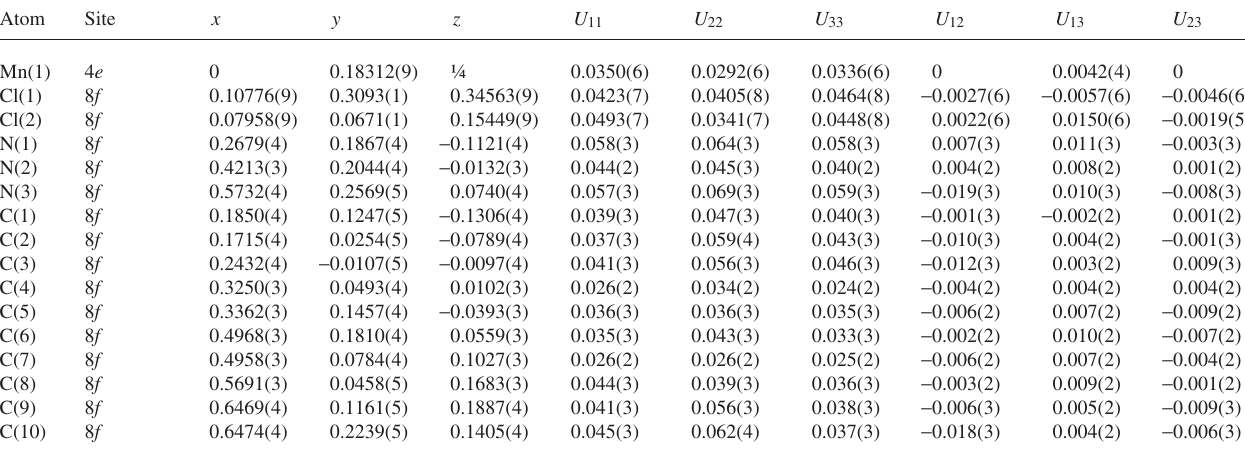
Table 3. Atomic coordinates and displacement parameters (in Å 2 )